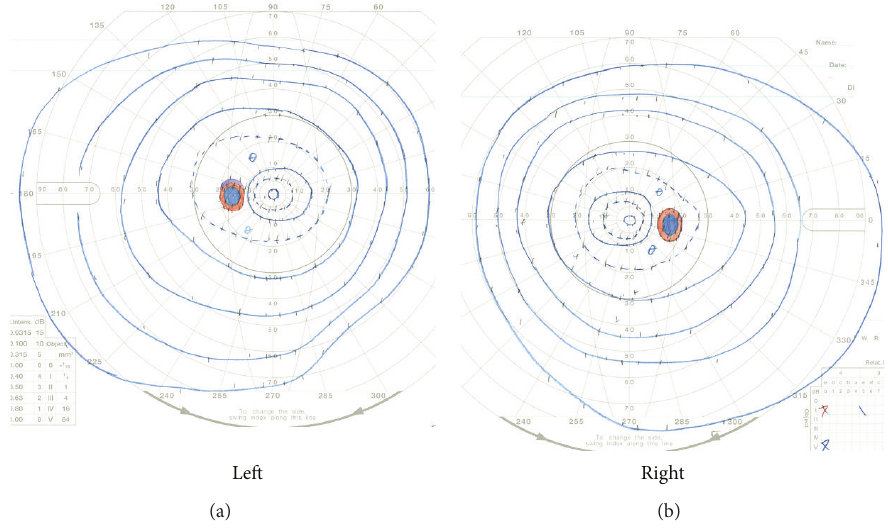
Figure 2: No visual disturbance was apparent.